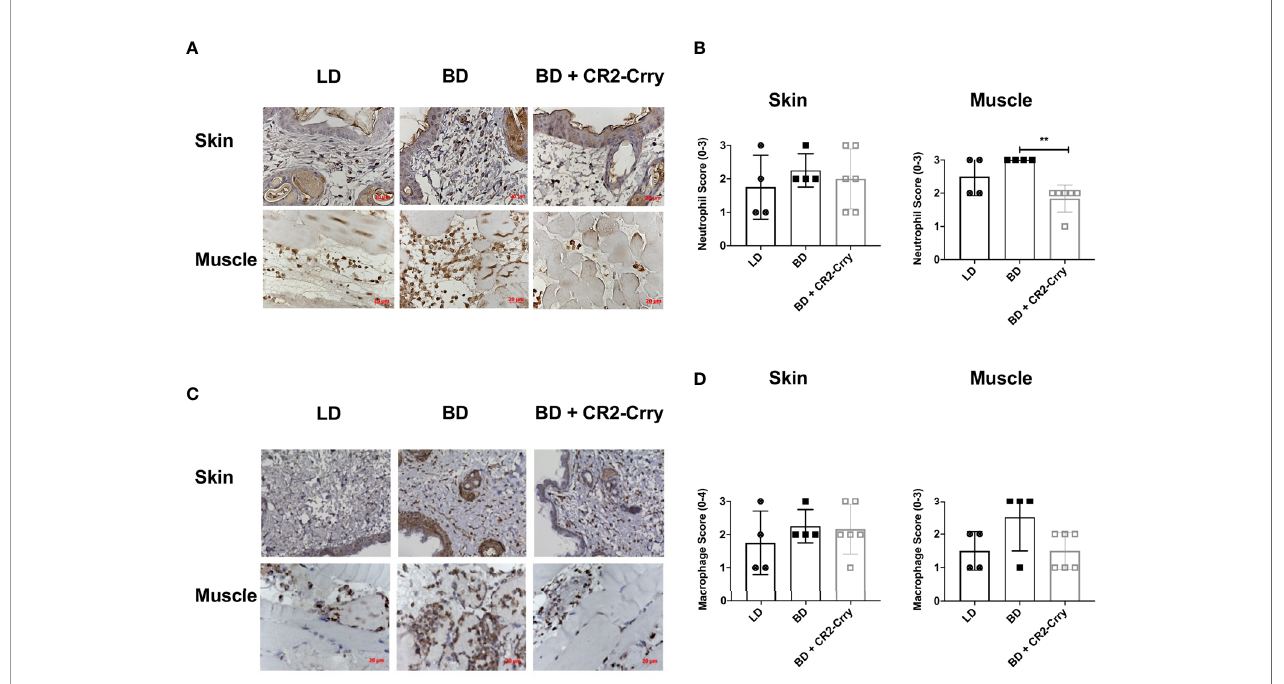
FIGURE 5 | Pretransplant perfusion of BD donor grafts with CR2-Crry reduces immune cell in fi ltration at 48 hours post-transplantation. (A) Representative images of muscle and skin sections stained by IHC for neutrophils (Nimp). (B) Quanti fi cation of neutrophil in fi ltration in skin and muscle, showing a reduction in neutrophils in muscle of BD CR2-Crry treated donors as compared to BD control group (**p = 0.008). (C) Representative images of muscle and skin sections stained by IHC for macrophages (Mac-3). (D) Quanti fi cation of macrophage in fi ltration in skin and muscle, showing no signi fi cant reduction in macrophages in both skin and muscle of BD CR2-Crry treated donors as compared to BD or LD control